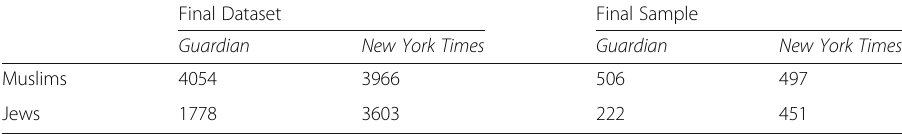
Table 1 Distribution of Guardian and New York Times Headlines, 1985 –